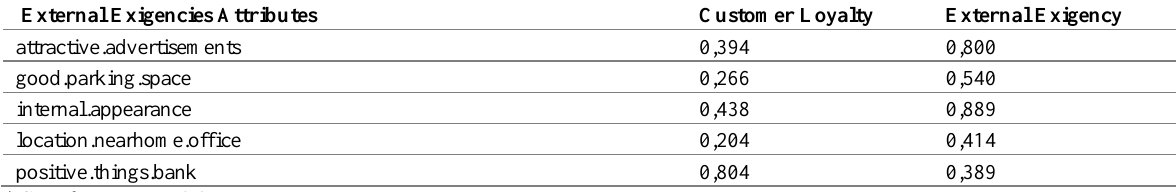
Table 6: Cross-loadings (Correlations) of External Exigencies attributes on Customer Loyalty External Exigencies Attributes Customer Loyalty External Exigency attractive.advertisements 0,394 0,800 good.parking.space 0,266 0,540 internal.appearance 0,438 0,889 location.nearhome.office 0,204 0,414 positive.things.bank 0,804 0,389 * Significant at P≤